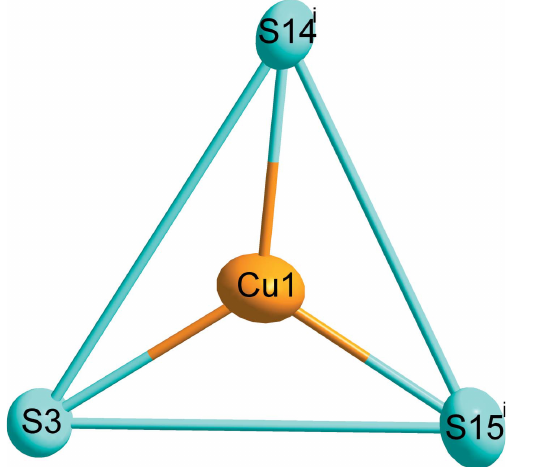
Figure 3 The environment of Cu48. Displacement ellipsoids are drawn at the 90% probability level. [Symmetry code: (iii) x , y (cid:4) 1, z .]